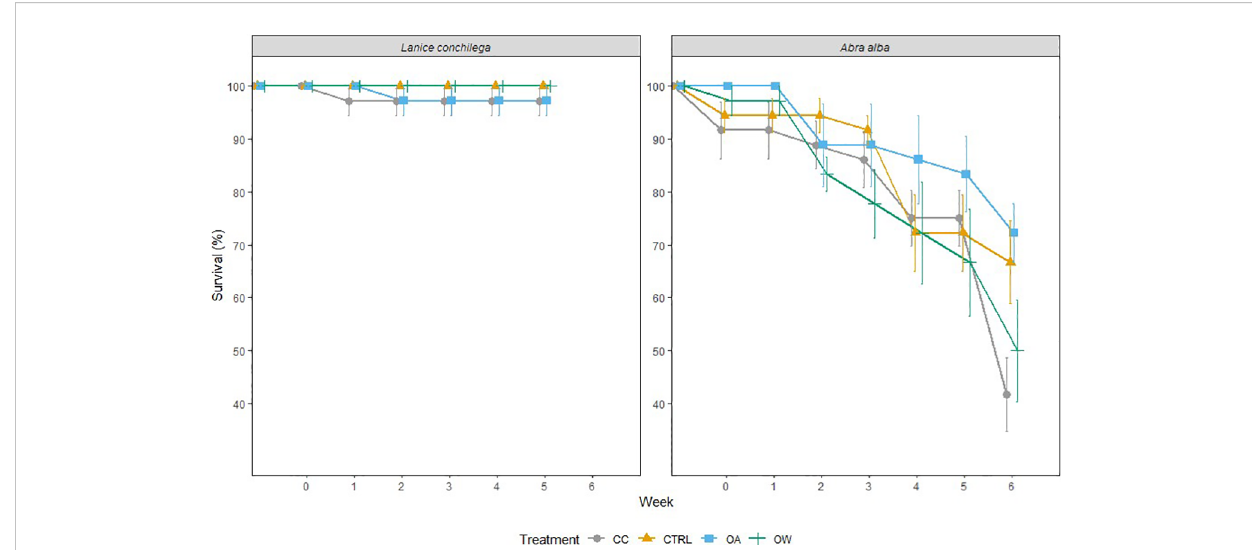
FIGURE 1 Effects of temperature and pH on the survival rate of A. alba and L. conchilega during the 6-week incubation period. Error bars represent standard errors (± SE, n =